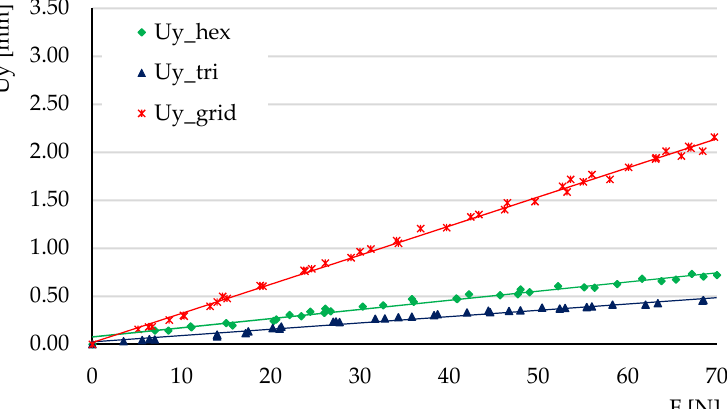
Figure 18. The comparative analysis of the variation of deflection Uy = f ( Fy ) for the hexagonal, triangle and grid structures, in experimental three-point bending.